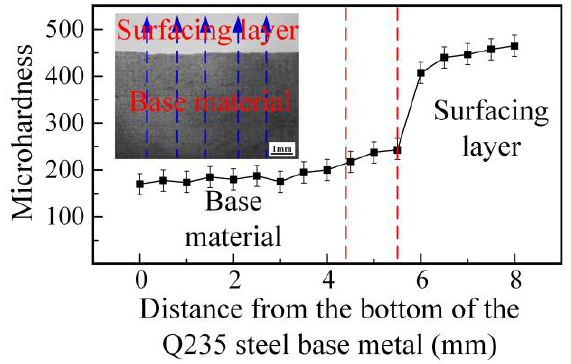
Figure 7. Hardness indentation paths and hardness profile.